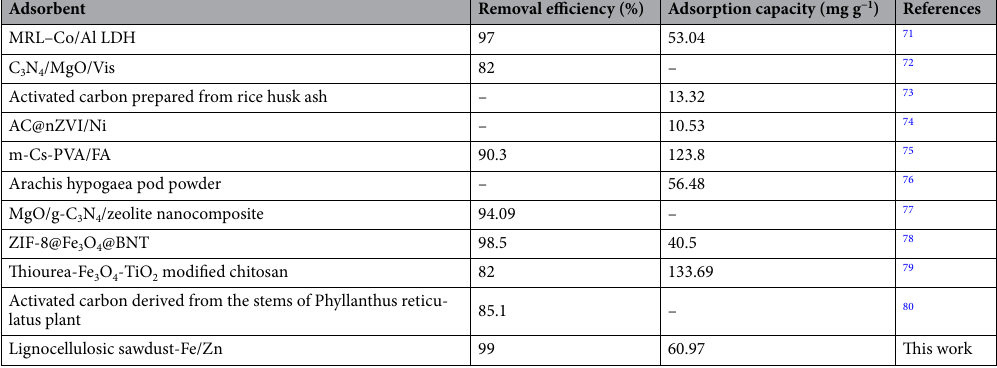
Table 4. Comparison with other adsorbents for the removal of